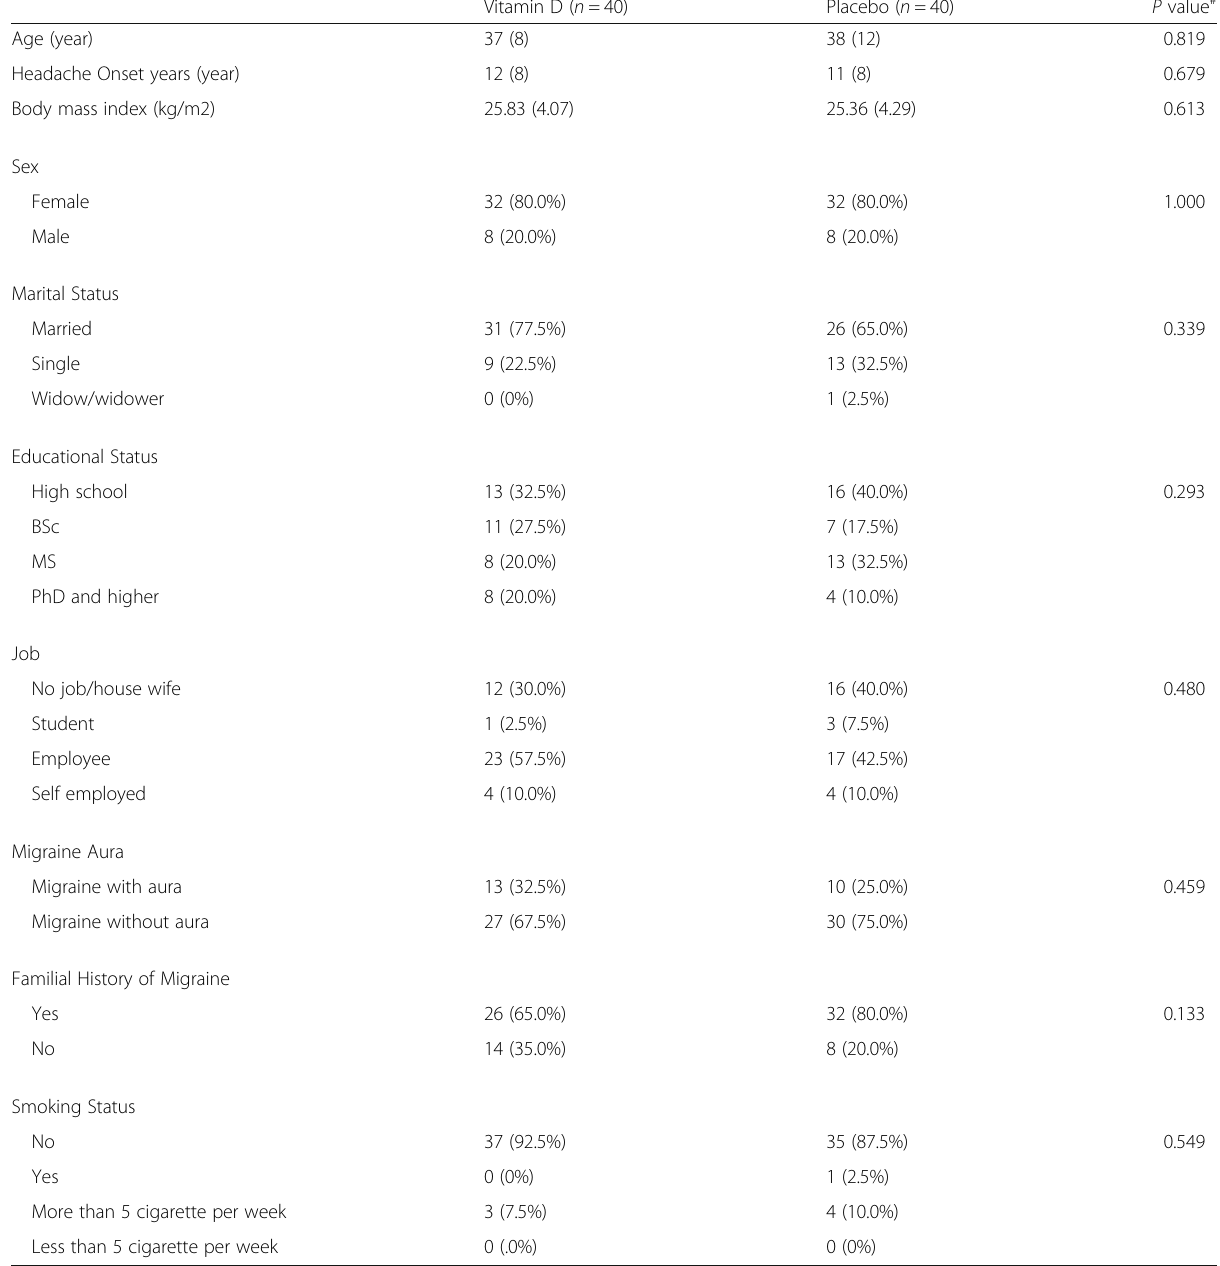
Table 1 Baseline demographic, anthropometric and clinical data of episodic migraine patients in a randomized controlled trial of vitamin D vs.